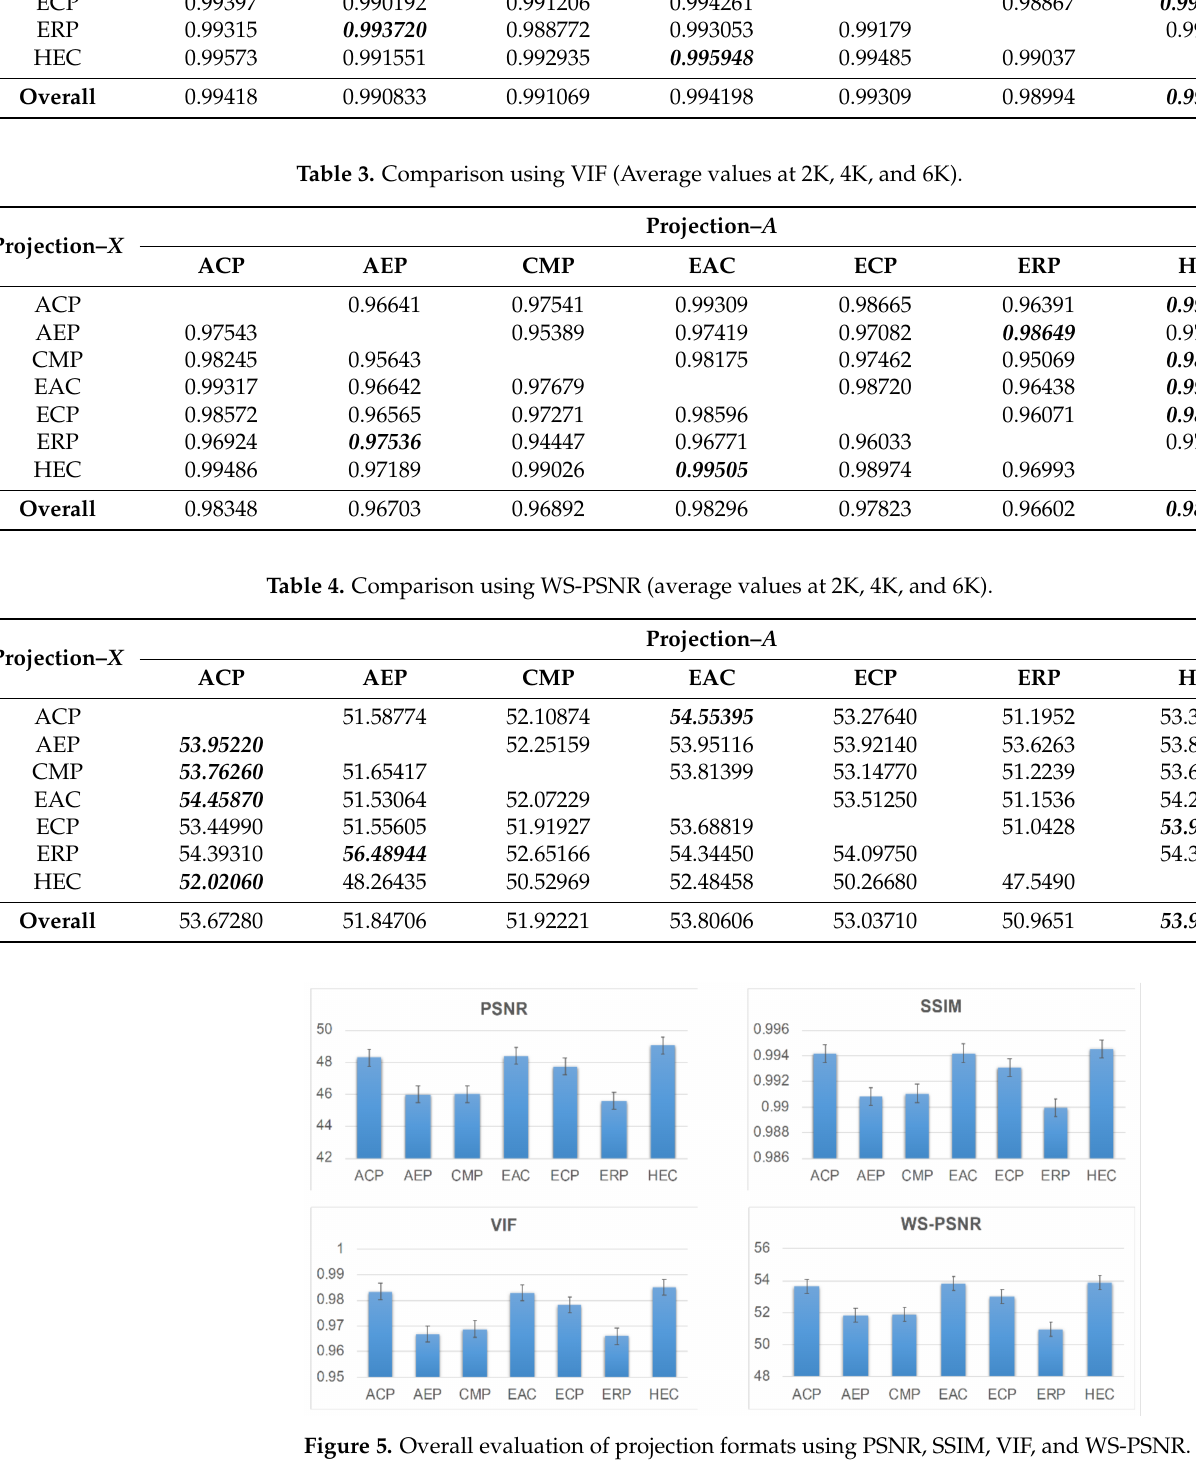
Figure 5. Overall evaluation of projection formats using PSNR, SSIM, VIF, and